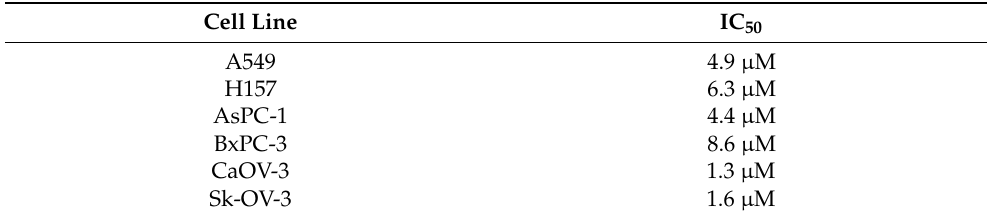
Figure 2. SBP-101 treatment reduces cancer cell viability in vitro. Lung, pancreatic, and ovarian adenocarcinoma lines were treated with SBP-101 concentrations ranging from 1 to 10 µ M. Cells were collected, and the number of viable cells (determined by trypan blue exclusion) was counted following treatment. SBP-101 treatment reduced the cellular viability in all treated lung ( A ), pancreatic ( B ), and ovarian ( C ) cancer cell lines. IC 50 values are listed in Table 1. Table 1. IC 50 values following SBP-101 treatment in cancer cell lines.